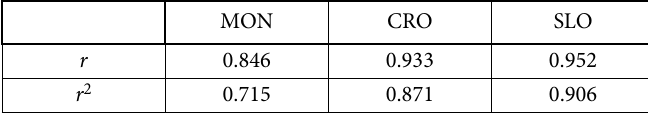
Table 1. Coefficient correlation ( r ) and Coefficient of determination ( r 2 ) MON